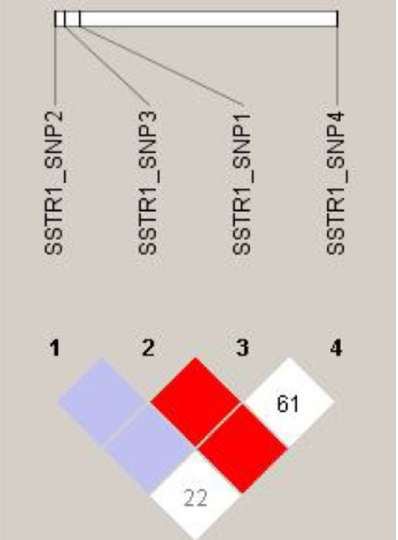
Figure 5. The linkage disequilibrium plot of SNPs in SSTR1 of in Hulun Buir sheep. Linkage dise- quilibrium (LD) estimated among SSTR1 variations in Hulun Buir sheep. The R2 values indicated the group of SNP1, SNP3, and SNP4. Table 2. Population genetics analyses of SSTR1 of in Hulun Buir sheep 1.